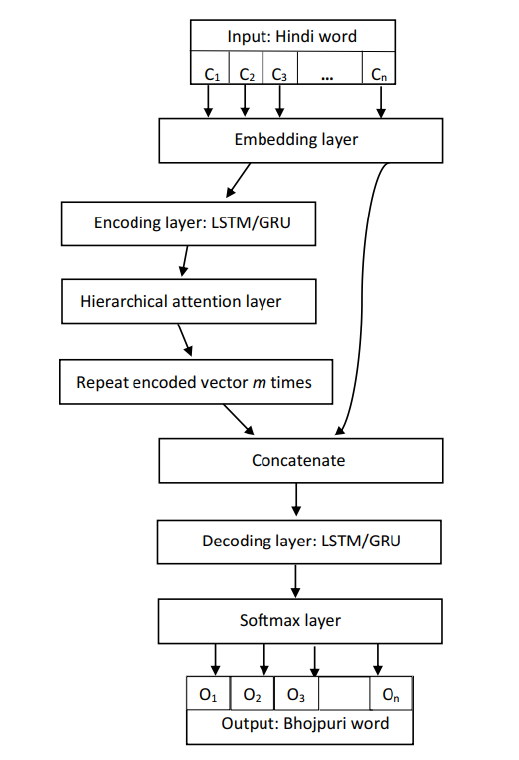
Encoder–decoder network architecture with HAN: n and m denote the number of characters in input and output